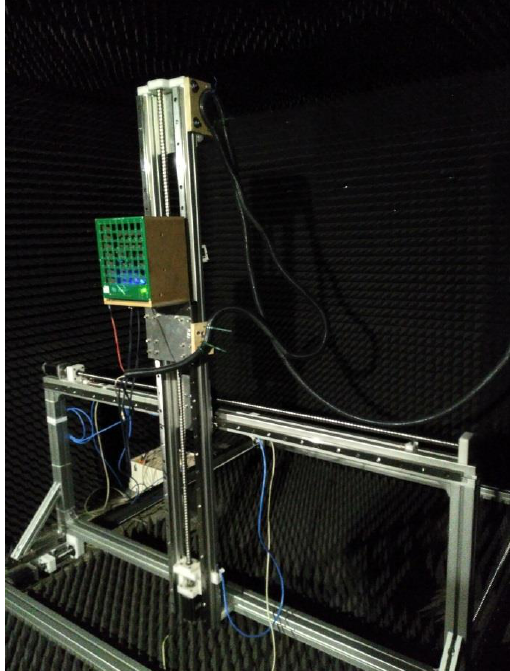
Figure 4. 3D positioning system.